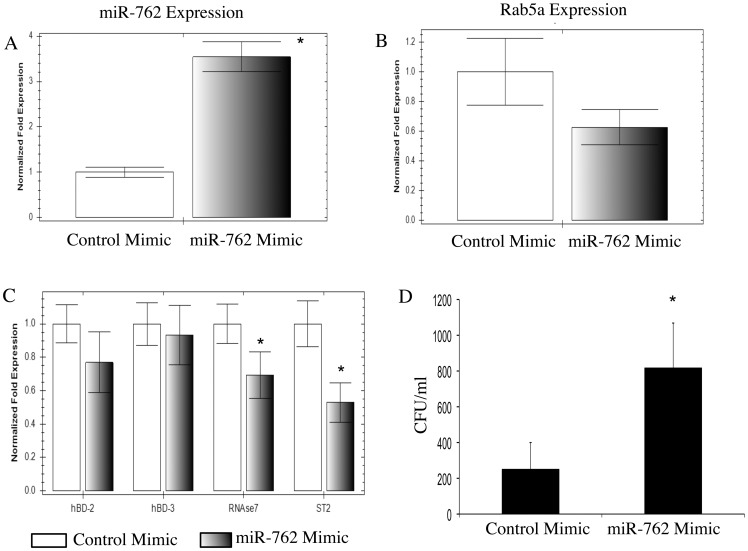
The effect of a miR-762 mimic on gene expression in human corneal epithelial cells and on P. aeruginosa invasion.a Transfection of human corneal epithelial cells with a mimic of miR-762 increased the expression of miR-762 relative to a control (scrambled) mimic, b decreased Rab5a mRNA expression (although that difference was not significant), c significantly decreased mRNA expression of RNase7 and ST-2, but not that of hBD-2 or hBD-3, and d increased P. aeruginosa invasion (* p  =  0.044, t-Test). Gene expression was measured by real-time PCR, and P. aeruginosa invasion using gentamicin exclusion assays. In each experiment, cells were used at 48 h after transfection. At 72 h, epithelia were challenged with 104 cfu P. aeruginosa strain 6294 for 3 h followed by 1 h gentamicin treatment (see Methods). (* Significant difference vs. respective controls, t-Test).